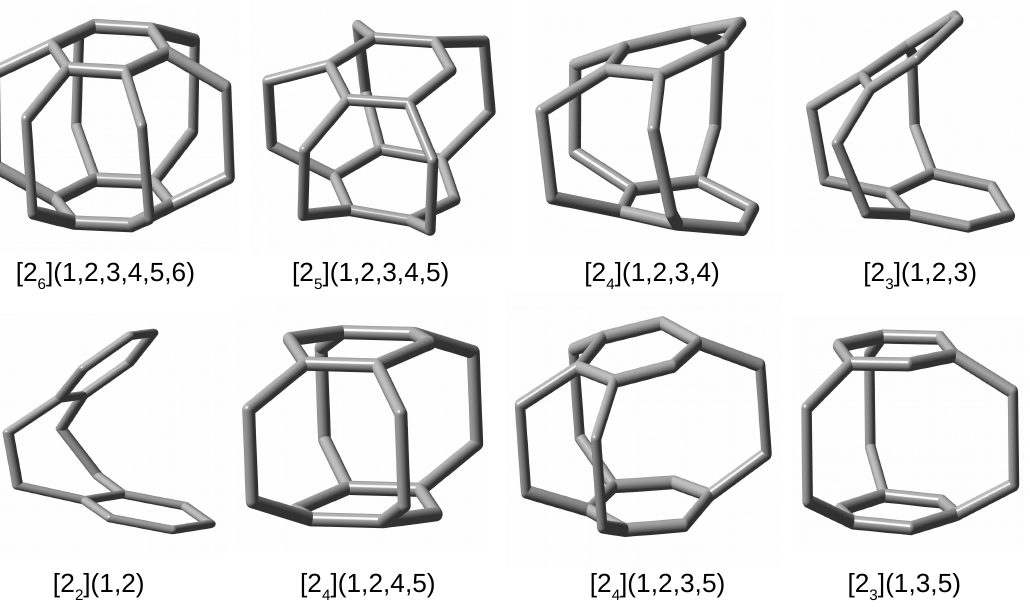
Figure 4. Structures of cyclophanes (hydrogen atoms have been removed for better visualization of the carbon